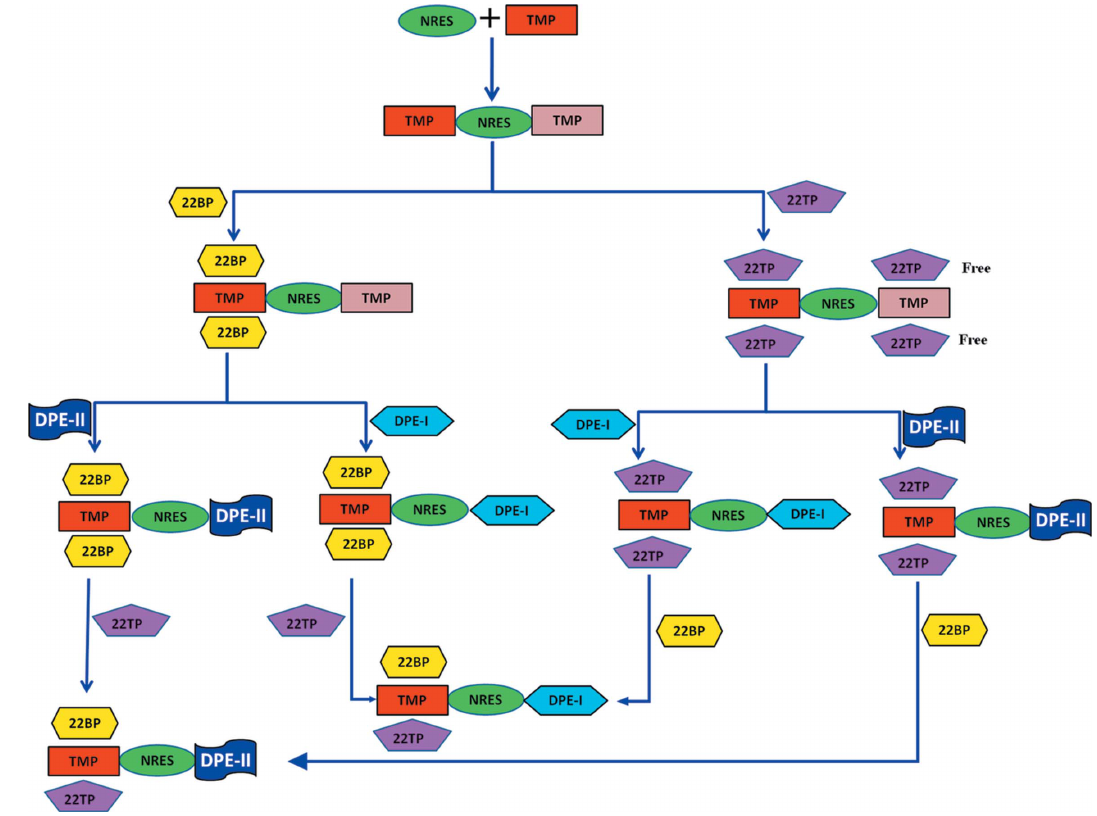
Figure 1 Schematic for the construction of five-component cocrystals. Reproduced from Rajkumar & Desiraju